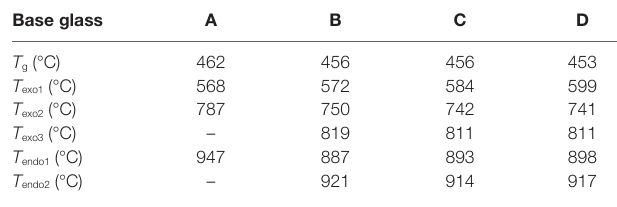
TaBle 2 | Thermal analysis of the base glasses by means of